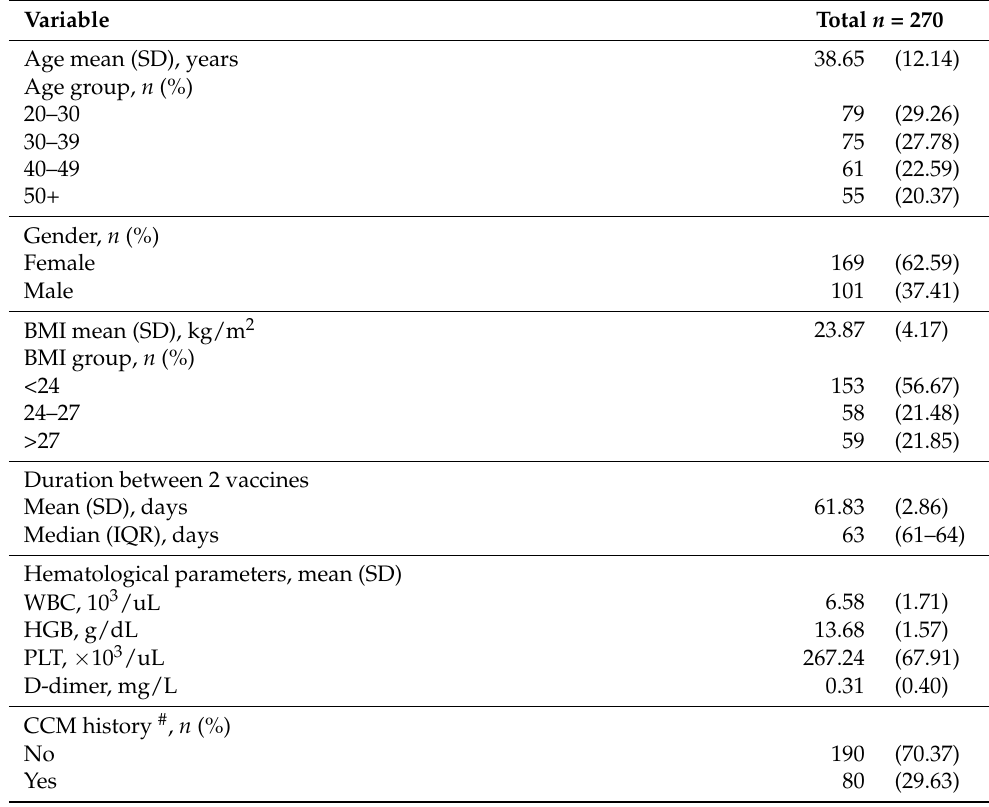
Table 1. Baseline characteristics of vaccination